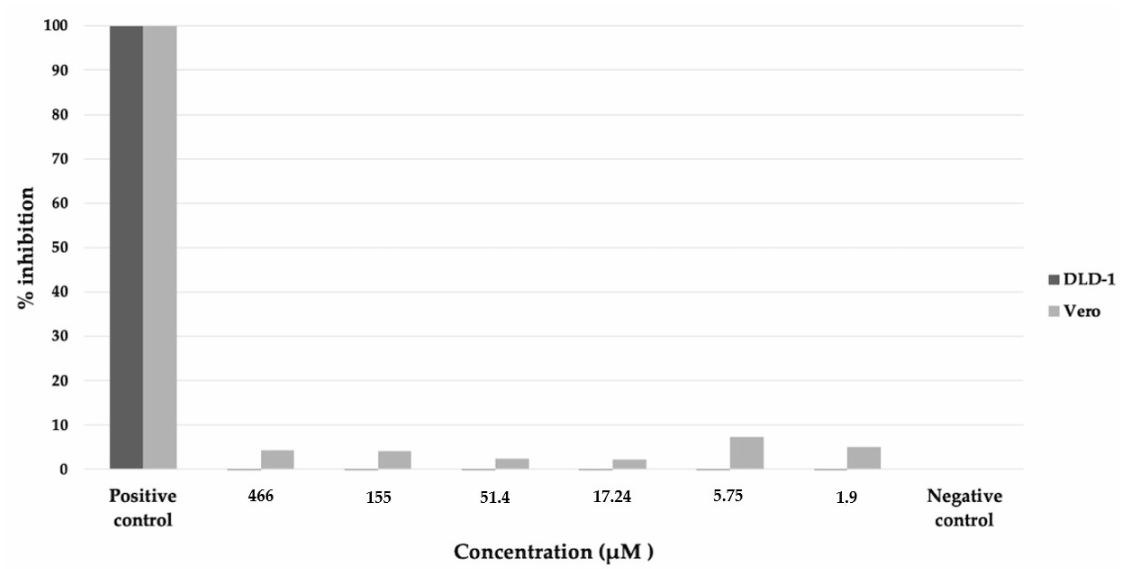
Figure 11. Cytotoxicity assay of nornidulin against colorectal adenocarcinoma (DLD-1, dark bar) and African green monkey kidney (Vero, light bar) cell lines. The assay was performed using CCK-8 method (see Materials and Methods). Positive control, culture medium without cell; negative control, cell culture without